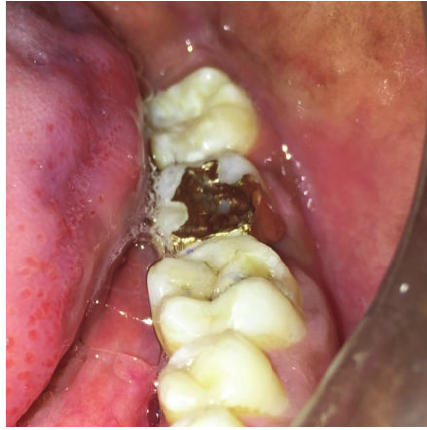
Figure 24: Photograph showing stabilization of fractured cusp with respect to 46.